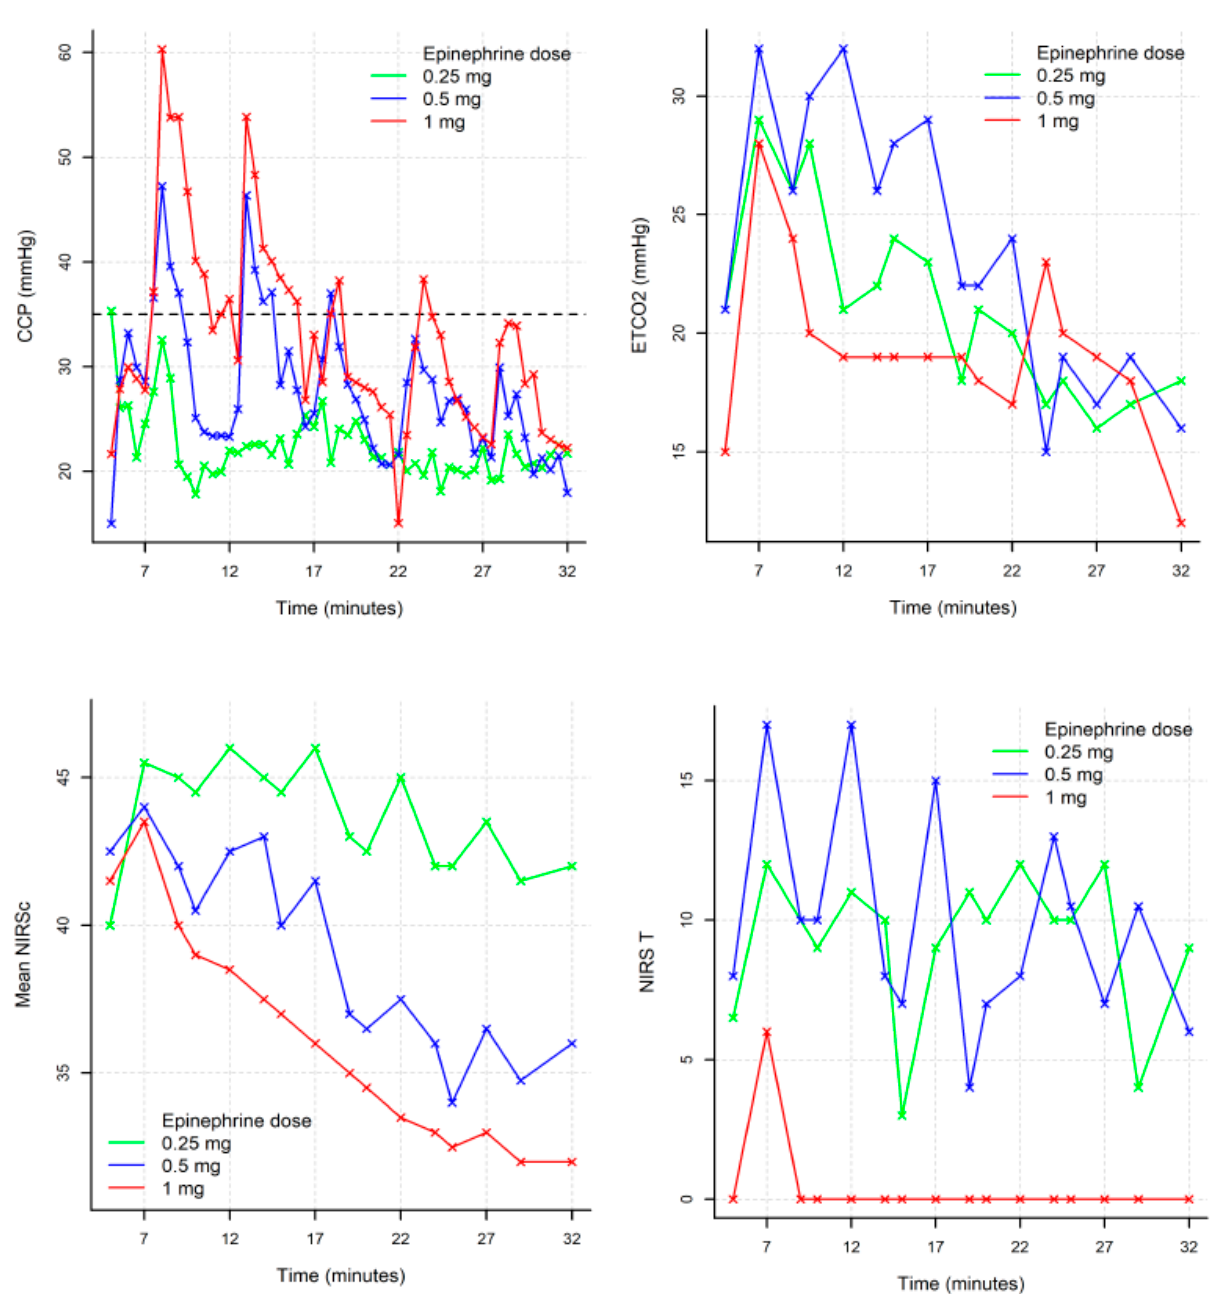
Figure 2. Variation in CPP, EtCO 2 , cerebral, and tissular NIRS for each group (median). EtCO 2 levels between T7 and T9 (two minutes after the first adrenaline injection) were not significantly different. EtCO 2 is higher in the 0.5 mg group than the 1 mg group at T12, T14, and T17 with 32 (23; 35), 26 (20; 34), and 29 (22; 37), respectively ( p = 0.016, p = 0.032, and p = 0.016). There was no significant difference for any other timing (Table 4) (Figure 2). At T32, NIRSc was of 42% (39.5; 59.5) for 0.25 mg; 36% (32; 49) for 0.5 mg, and